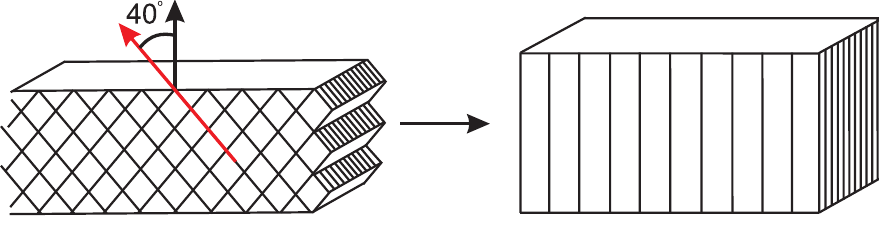
Figure 29. Suggested deformation of a γ -crystal with the orthorhombic unit cell structure at a temperature of 110 ◦ C. The newly formed lamellar crystal is comprised of a monoclinic alpha unit cell